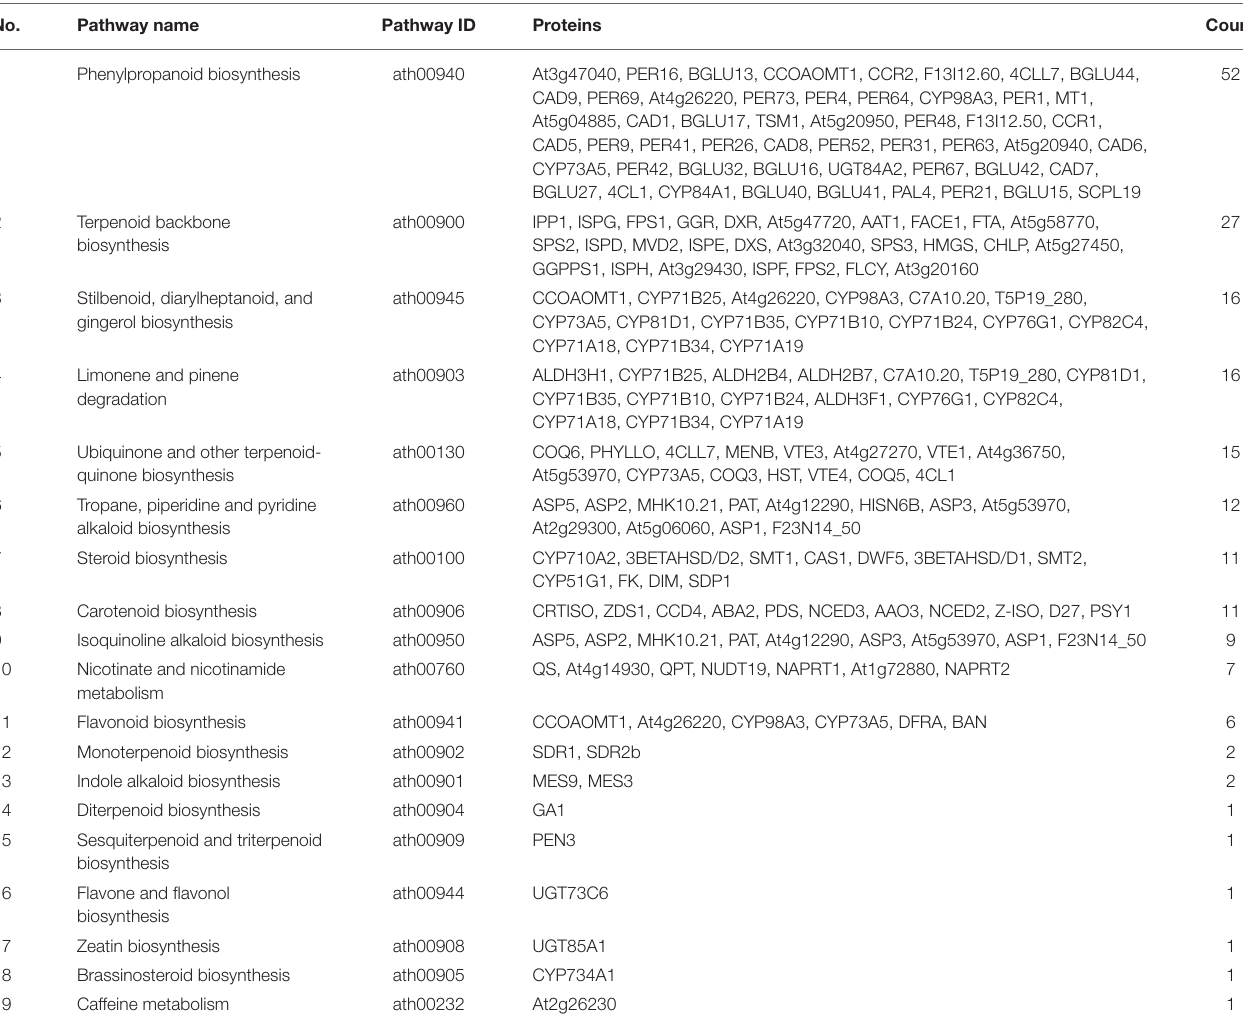
TABLE 2 | KEGG pathway on some secondary metabolites in roots of R. glutinosa .